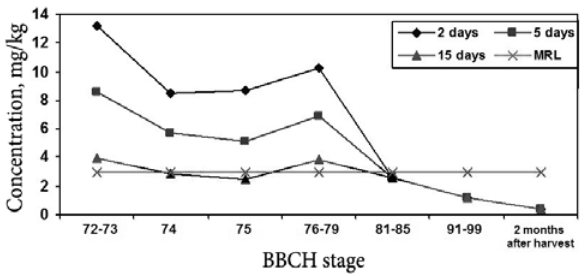
Fig. 8. Degradation of folpet in Jonathan apples